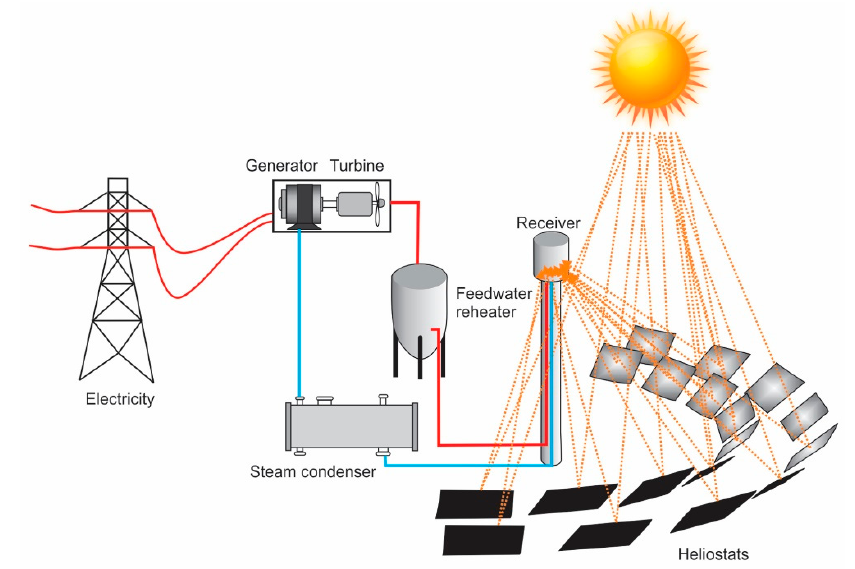
Figure 11. Solar thermal electricity generation by solar towers.